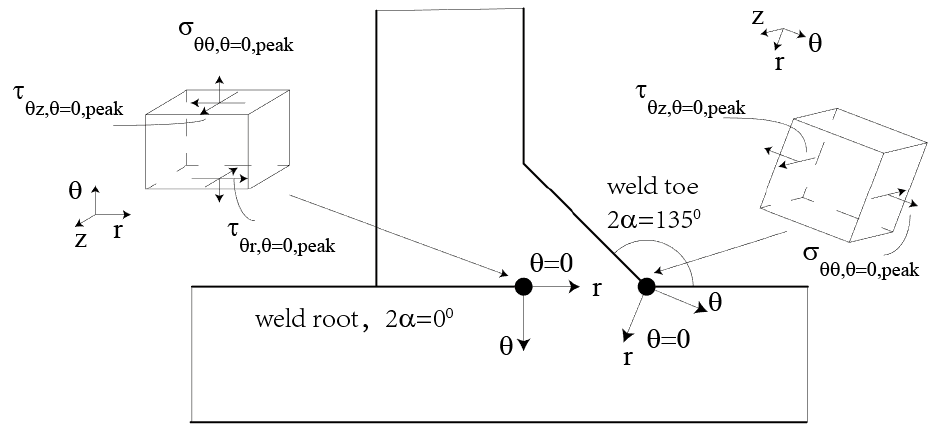
Figure 3. Definition of peak stresses assessed in weld toe and weld root.